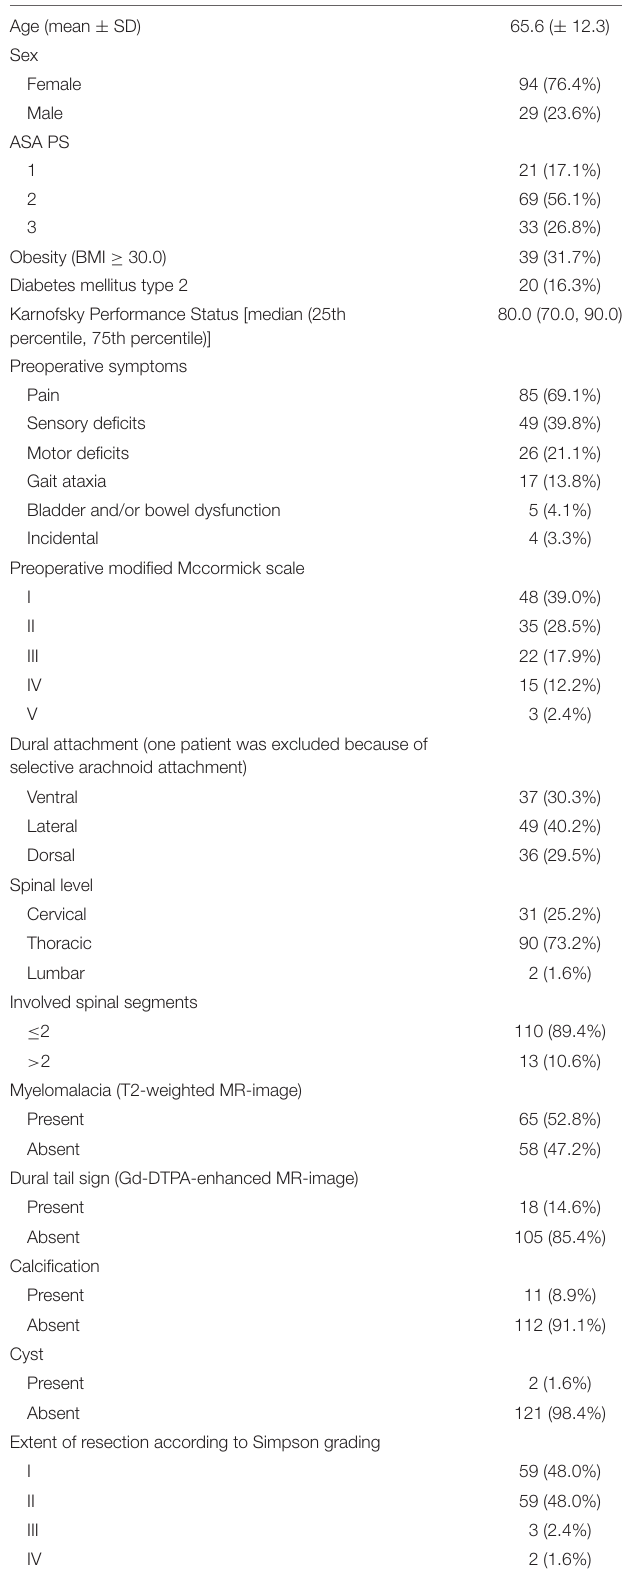
TABLE 1 | Baseline clinical, imaging and surgical characteristics of patients ( n =